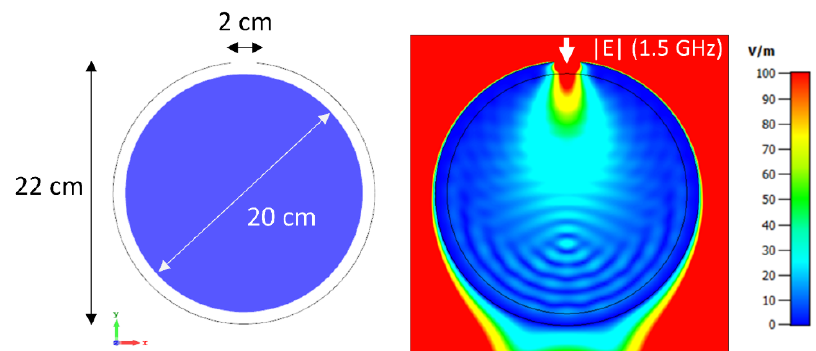
Figure 2. Depiction of the simulated 2D setup using a pure water phantom. A plane wave with E Z -polarization incident on a 2 cm aperture in a perfectly conducting shield is used as an excitation source to mimic a localized broadband radiofrequency applicator. In consecutive simulations, the aperture was rotated around the sample in 32 steps to provide completely circumscribing field sources. An exemplary E-Field plot is shown on the right.